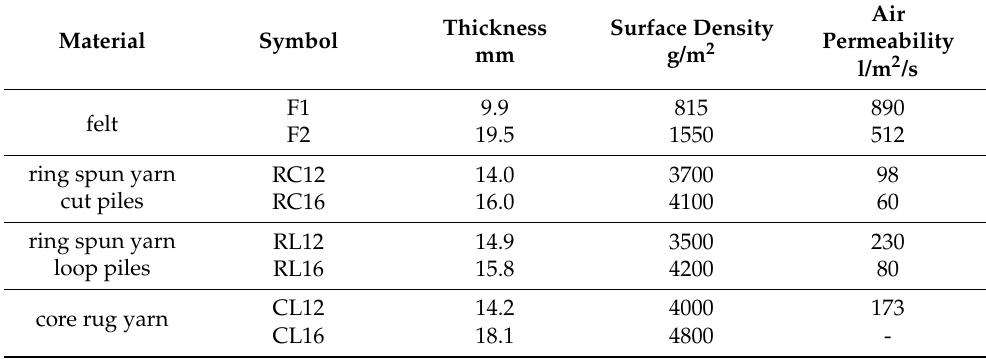
Table 1. Basic parameters of sound absorbing materials produced from mountain sheep